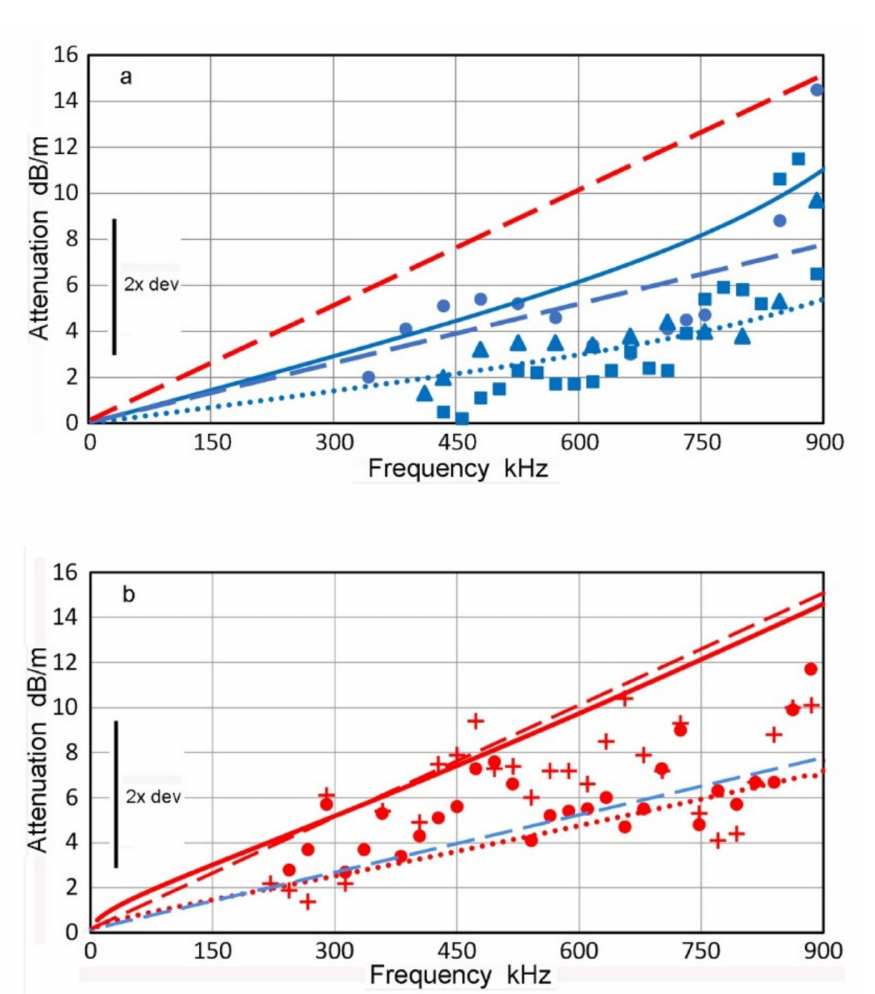
Figure 12. ( a ) Three sets of α –S o values for soda lime glass sheet of 2.0-mm thickness. All with Olympus V103 as Tx and KRN-BB-PC as Rx. Blue dots: Single-cycle sinewave at 600 kHz, Blue squares: Single-cycle sinewave at 750 kHz, Blue triangles: Single-cycle sinewave at 750 kHz, one- surface detection. Calculated α –S o (solid blue curve), α L and α T (blue and red dashed lines) are also plotted. Blue dotted curve was also for α –S o , but calculated using reduced α L and α T (see text). Vertical bar shows 2 × dev. ( b ) Two sets of α –A o values for soda lime glass sheet of 2.0-mm thickness plotted in red symbols. Both sets used single-cycle sinewave at 600 kHz with Olympus V103 Tx at 60 ◦ incident angle and KRN-BB-PC Rx. Calculated α –A o (solid red curve), α L and α T (blue and red dashed lines) are also plotted. α –A o (red dotted) used reduced α L and α T (see text). Vertical bar shows 2 ×